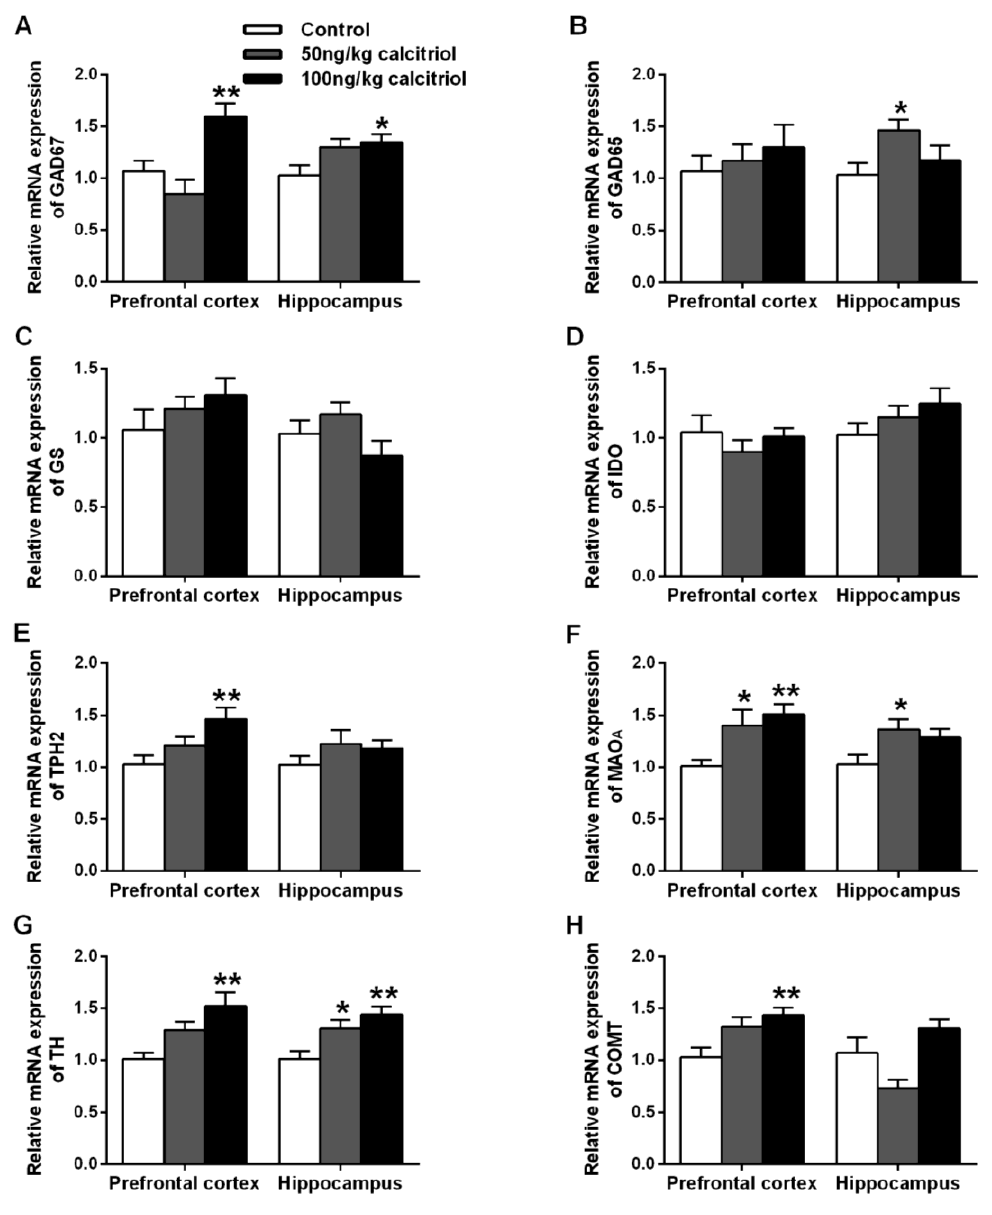
Figure 2. Effect of chronic calcitriol administration on mRNA levels of the metabolizing enzymes of the neurotransmitters in prefrontal cortex and hippocampus.